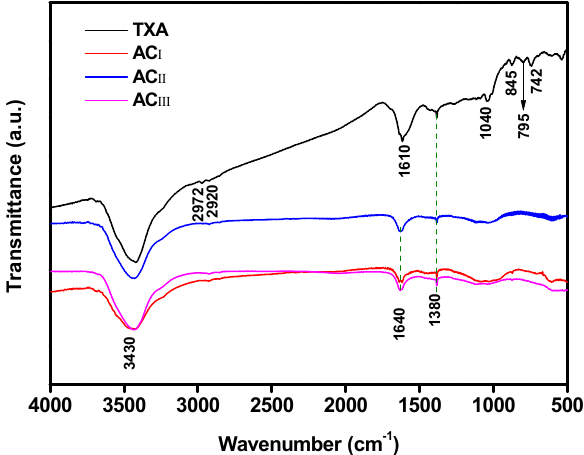
Figure 3. FTIR spectra of TXA, AC I , AC II and AC III .